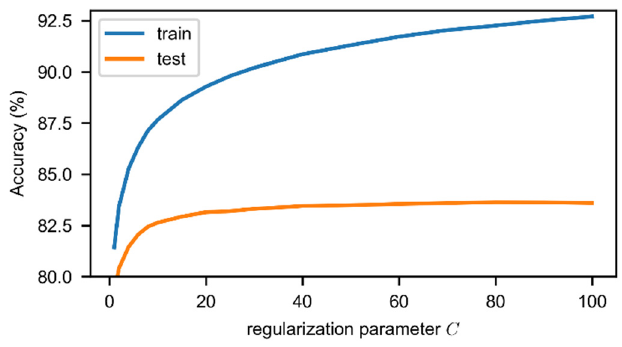
Figure A2. E ff ect of regularization parameter C on the accuracy of SVC in the proposed method.